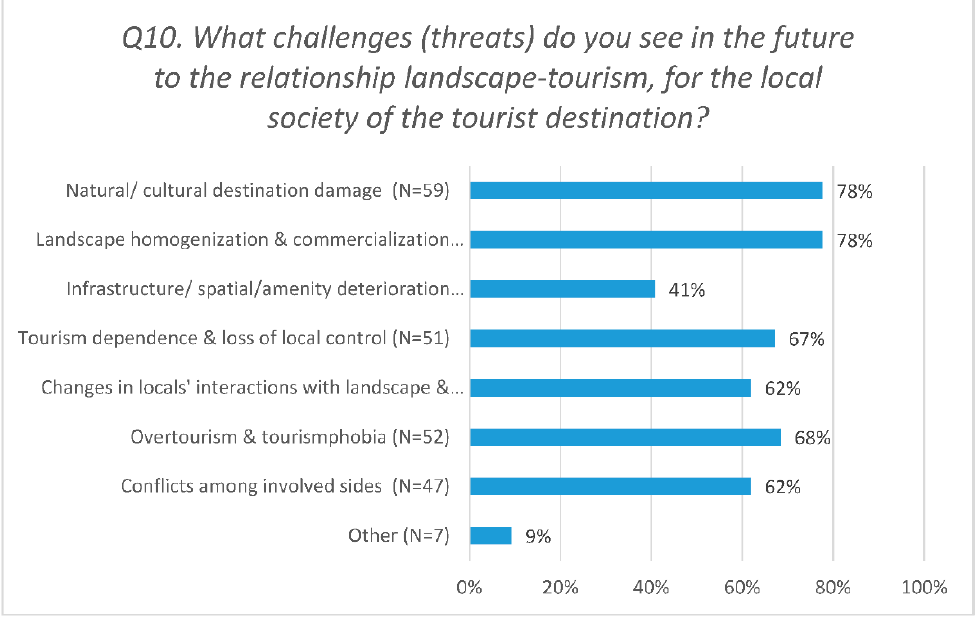
Figure 8. Challenges of the tourism–landscape relationship for the local society of the tourist desti- nation.